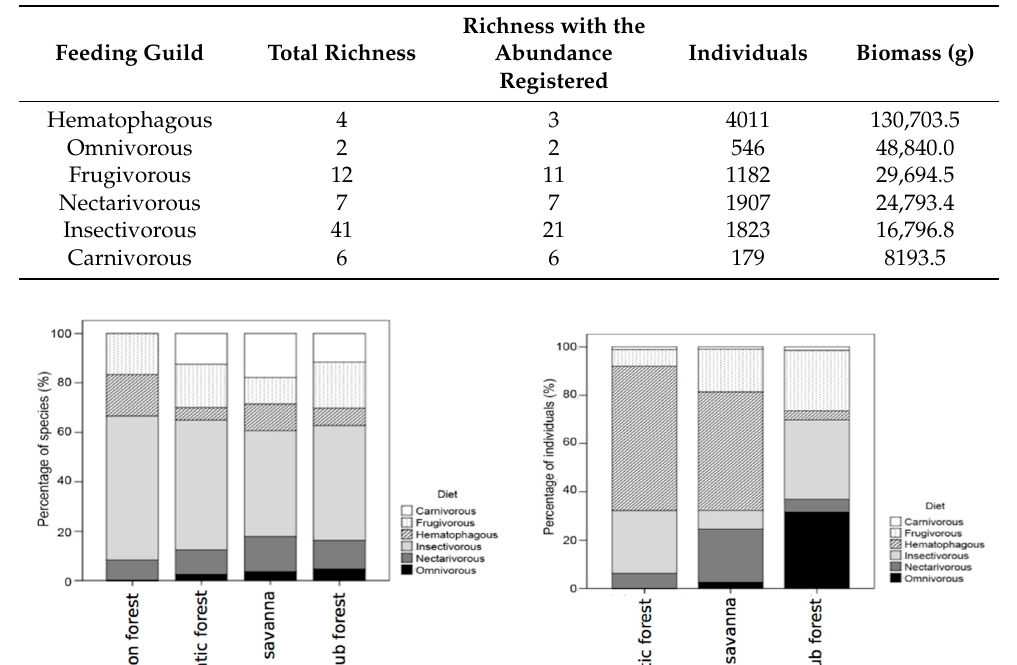
Figure 5. Richness ( a ) and abundance ( b ) of cave-dwelling bats by biome. Table 2. Richness, abundance, and biomass of the feeding guilds of Brazilian cave bats.